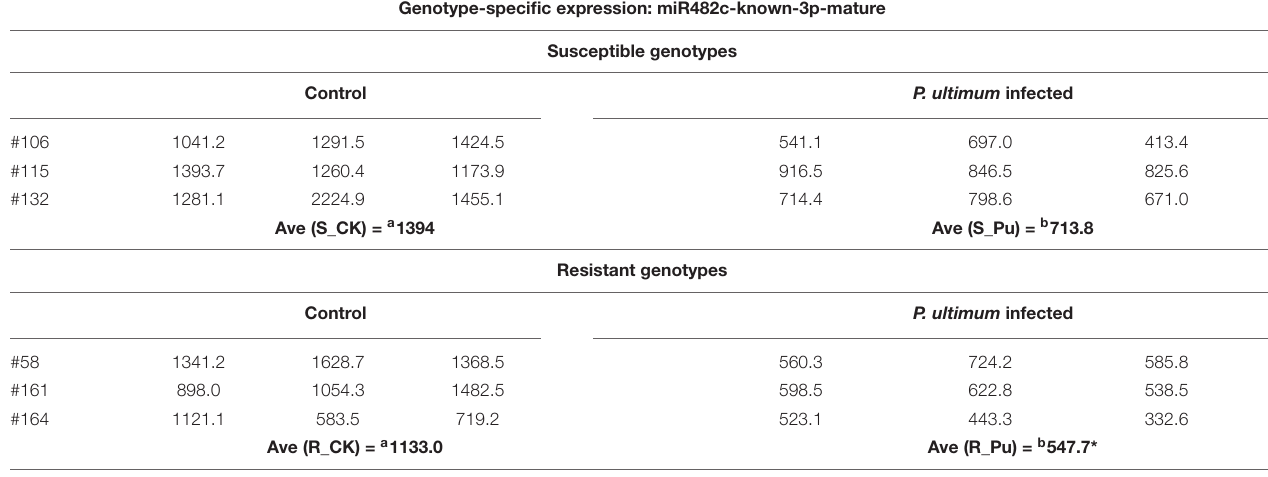
TABLE 6 | The genotype-specific expression of miR482c and target genes in response to Pythium ultimum infection of apple roots. Genotype-specific expression: miR482c-known-3p-mature